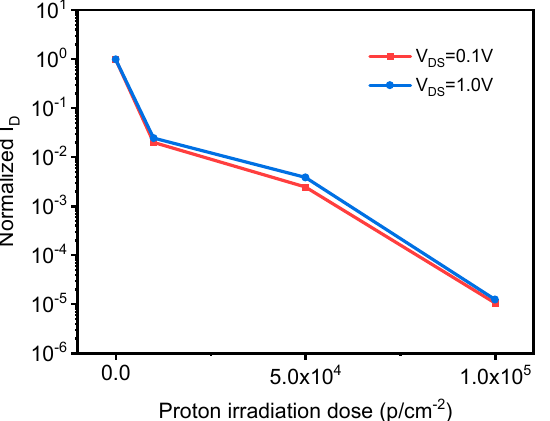
Figure 15. The normalized leakage current of graphene samples varies with proton irradiation dose.